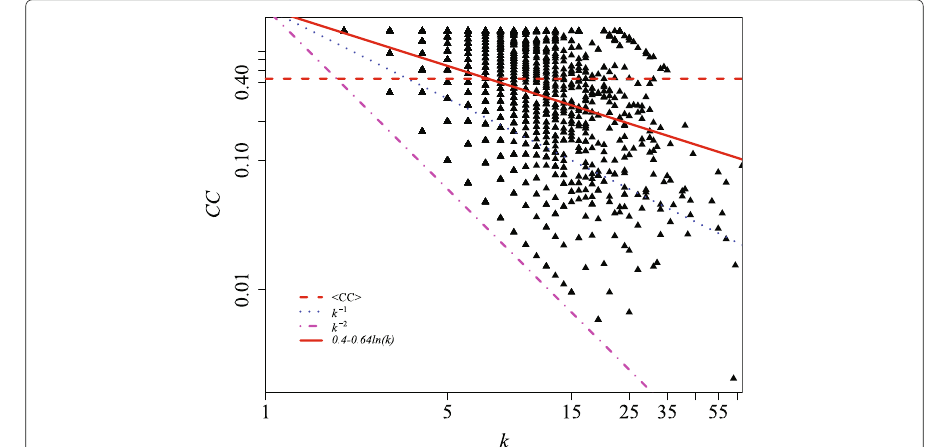
Fig. 4 Clustering coefficient ( CC ) as a function of the degree ( k ) in log-log representation. The horizontal dashed red line is the average clustering coefficient ( < CC > ∼ 0.43). The dotted blue line is CC ∼ k − 1 , the dotdashed magenta line stands for CC ∼ k − 2 and the solid red line is the linear fit ln ( CC ) = ( 0.40195 ± 0.02096 ) − ( 0.63820 ± 0.01287 ) × ln ( k ) with adjusted R 2 of 0.2923 and very